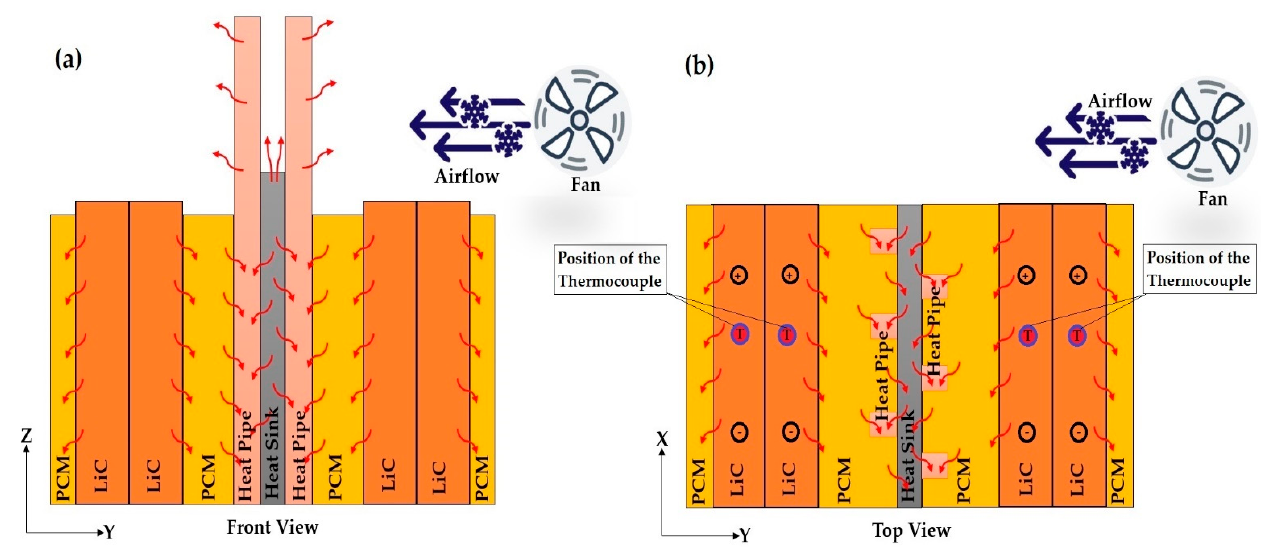
Figure 2. The heat transfer path diagram of the hybrid HPA-TMS that includes the air-cooling system, four prismatic LiC cells, paraffin PCM, six flat heat pipes, and a thin layer of aluminum heat sink: ( a ) Front View; ( b ) Top View. The thermocouples positions have also been added to clarify the point where the temperature evolution was monitored.